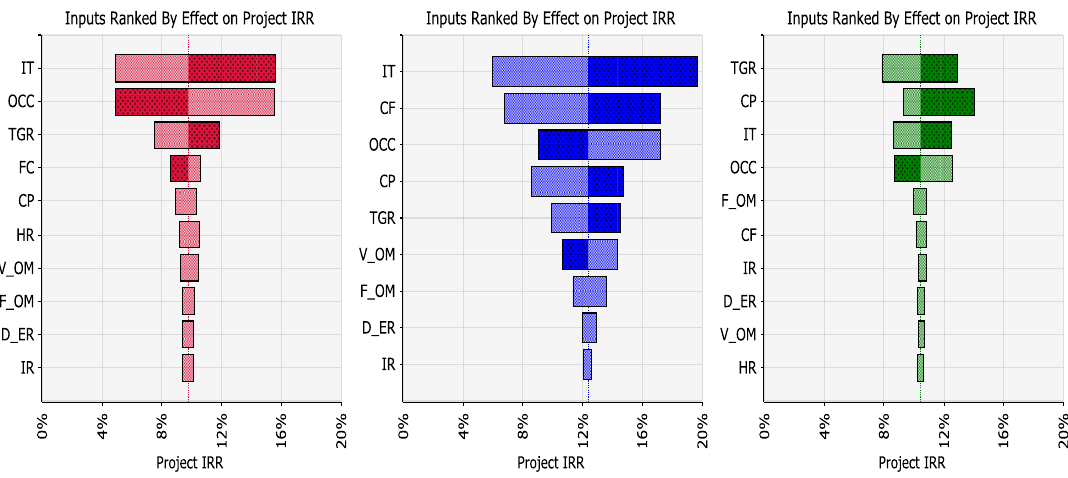
Figure 8. Project IRR tornado diagrams of Coal, Wind, and Nuclear.